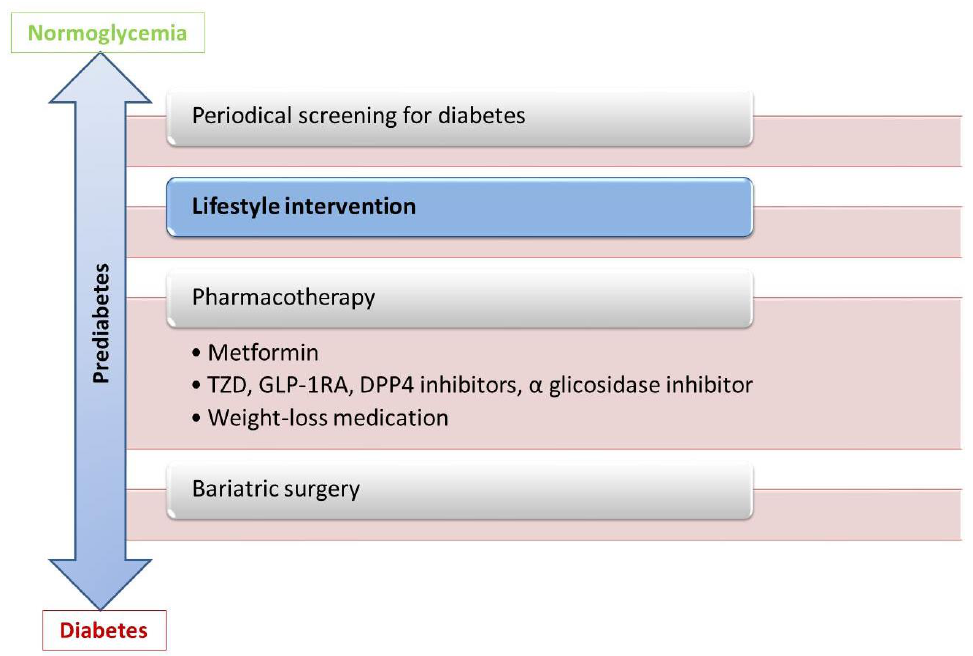
Figure 3. Possible interventions in intermediate glucose states. DPP4—Dipeptidyl peptidase-4, GLP—1RA-Glucagon-like peptide-1 receptor agonist,